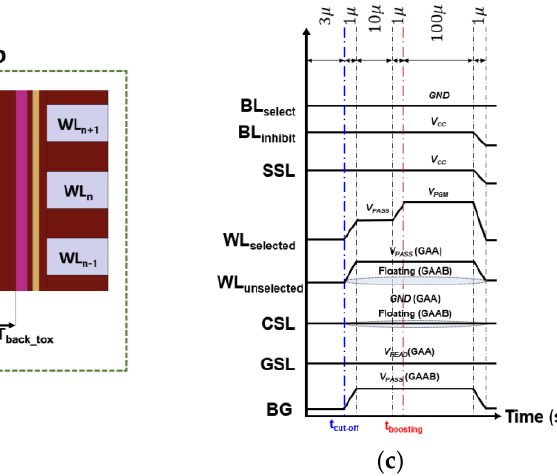
Figure 2. Schematics and cross-sections of 3D NAND flash memory: ( a ) Conventional GAA NAND and ( b ) Proposed GAAB NAND. ( c ) Timing diagram of program scheme in the GAAB NAND flash memory ( V CC :3V, V PGM : 20V, V PASS : 9V (standard), 12V,15V).